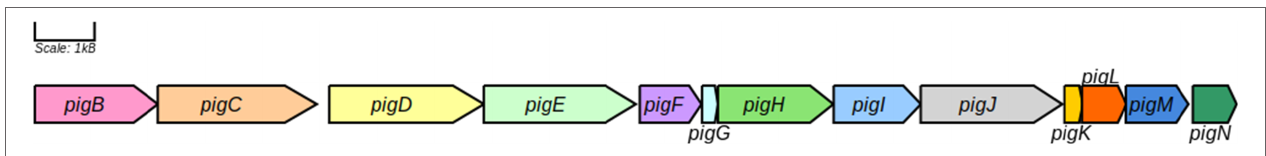
FIGURE 3 | Genetic arrangement of the clustered pig genes, pigB-pigN , on chromosome 1.